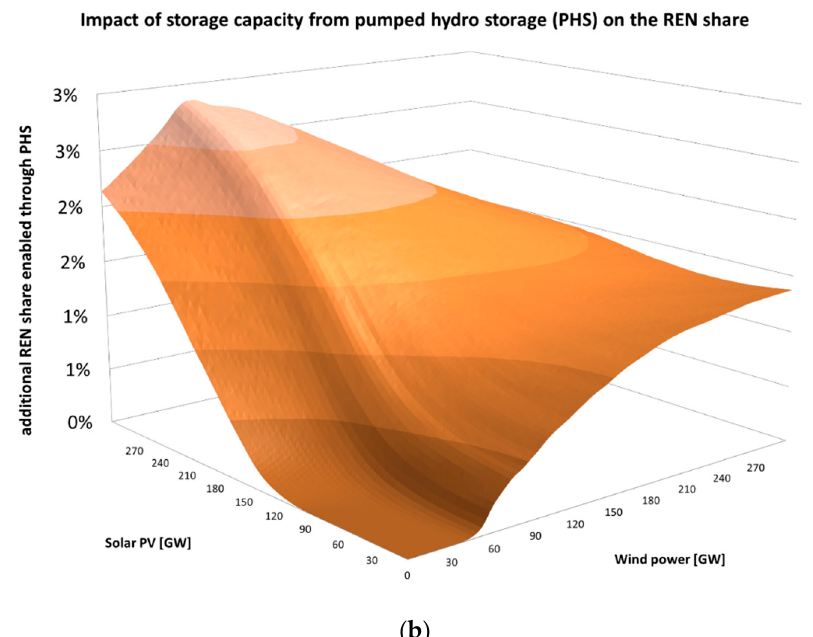
Figure 8. Differences surface plot for REN share illustrating the additional REN share enabled by electric energy storage from pumped hydro storage (PHS); ( a ) for the differences between the baseline cases and ( b ) for the differences between the advanced technology cases.